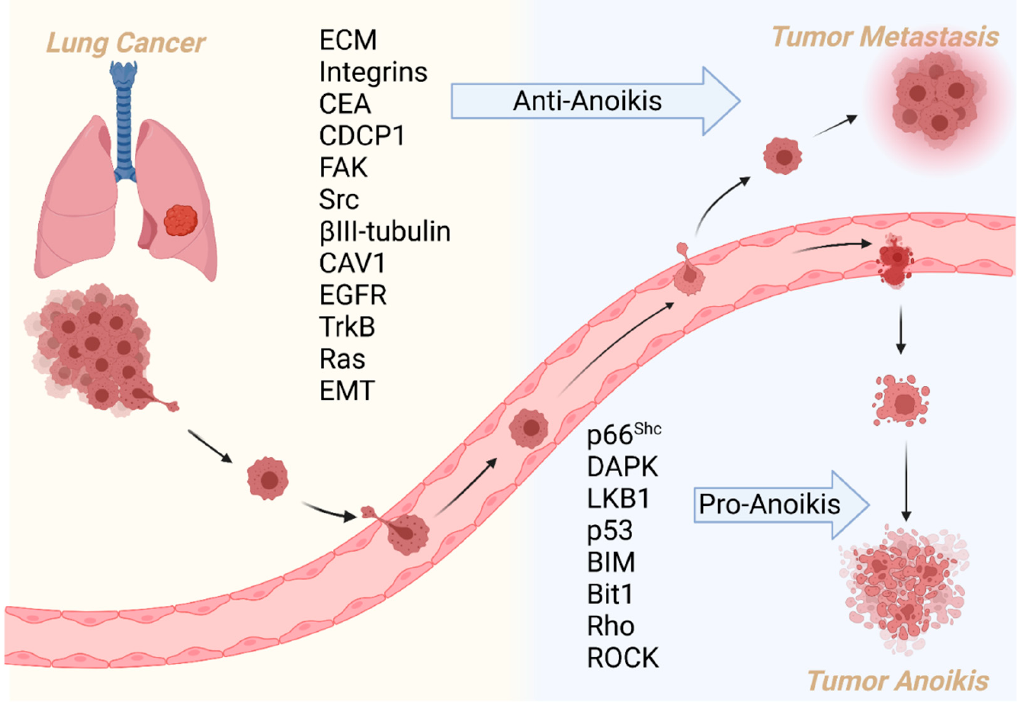
Figure 8. Overview of primary regulators in anoikis-associated lung cancer metastasis.